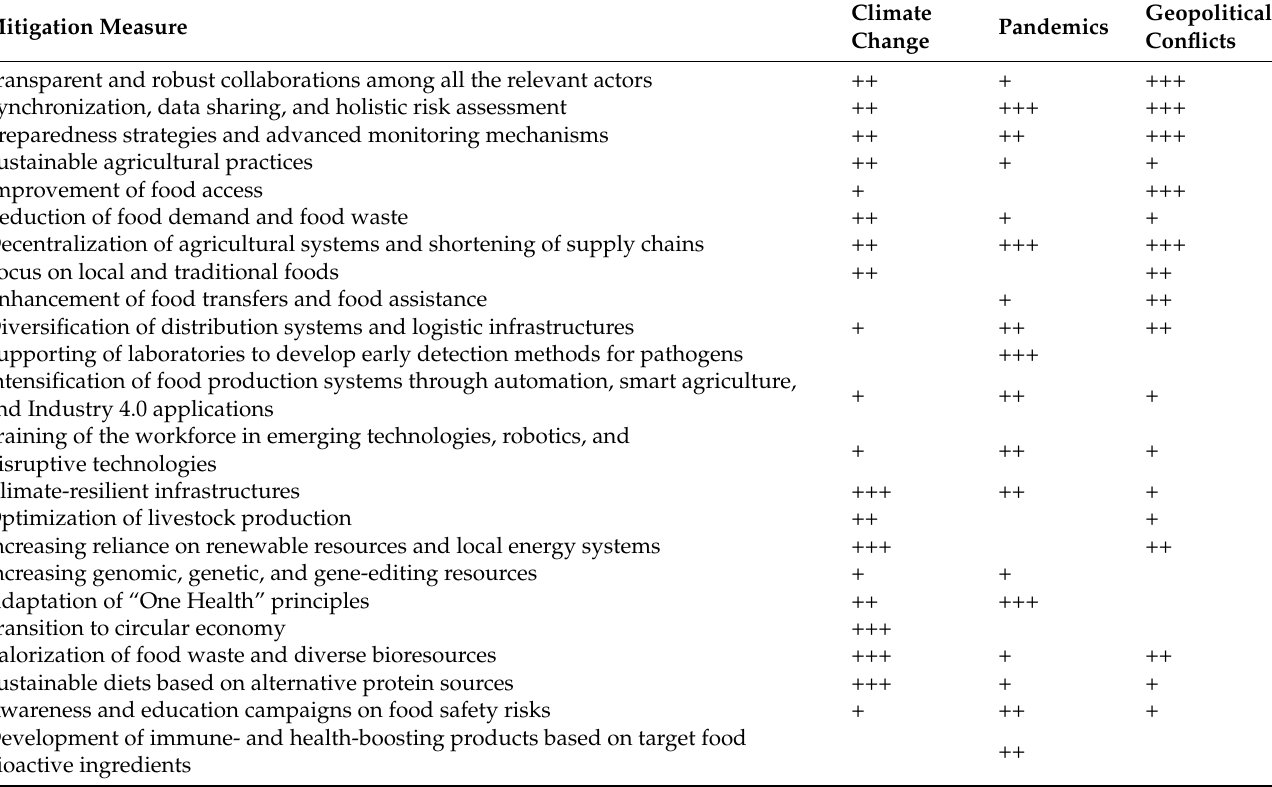
Table 1. Three different levels (“+” for low, “++” for medium, and “+++” for high) of mitigation measures to tackle the food sector challenges induced by various crises.